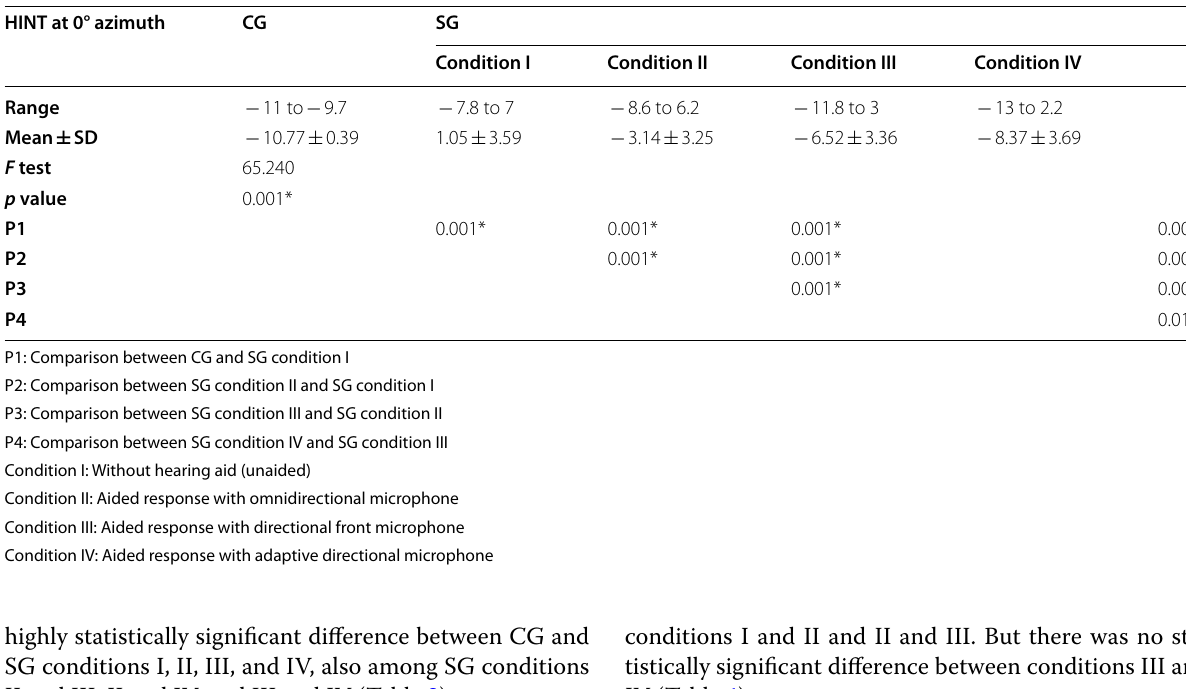
Table 3 Comparison among CG and SG conditions I, II, III, and IV using noise at 0° azimuth